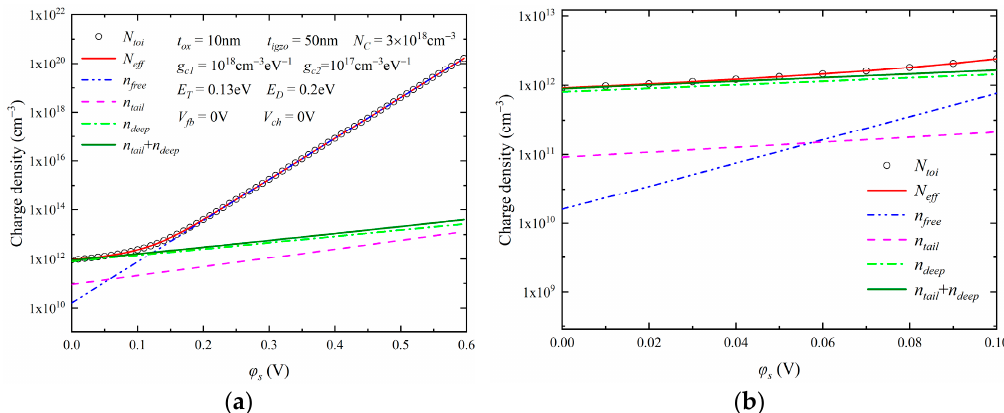
Figure 3. ( a ) Different charge densities versus surface potential curves with E T = 0.13 eV , E D = 0.2 eV and ( b ) partial enlarged view from 0 V–1 V.